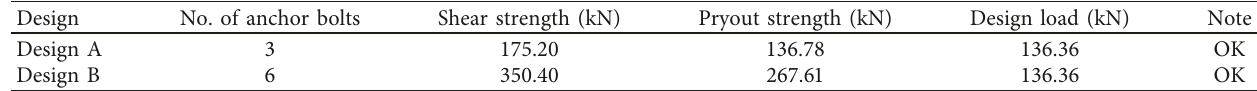
Figure 6: Overview of the anchor designs: (a) Design A and (b) Design B. Table 4: Postinstalled anchor bolts design and the design load.